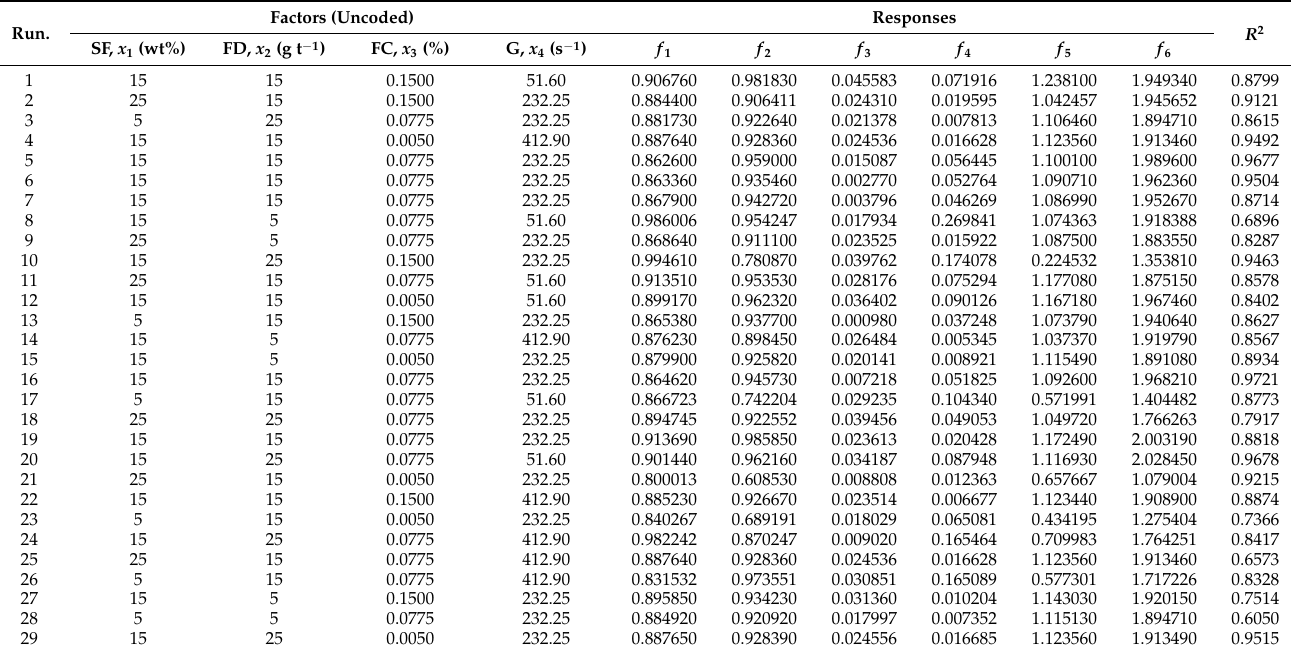
Table 1. Fitted parameters and statistics for each experiment run.